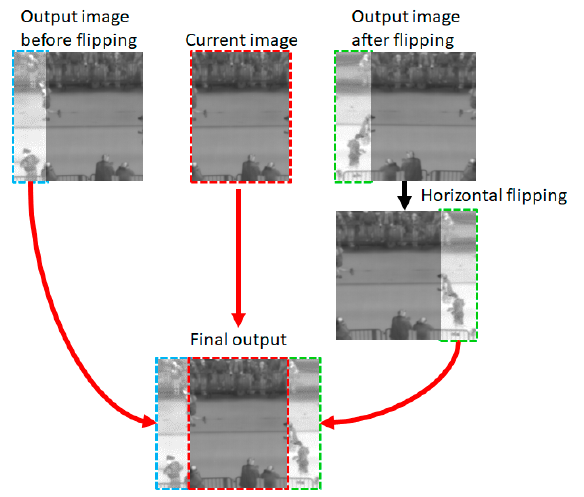
Figure 4. Example of the postprocessing.